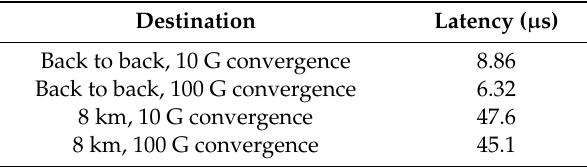
Table 1. Latency for di ff erent test scenarios.